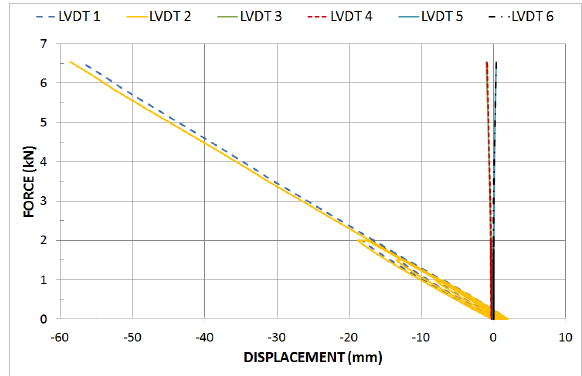
Figure 11. Force-Displacement